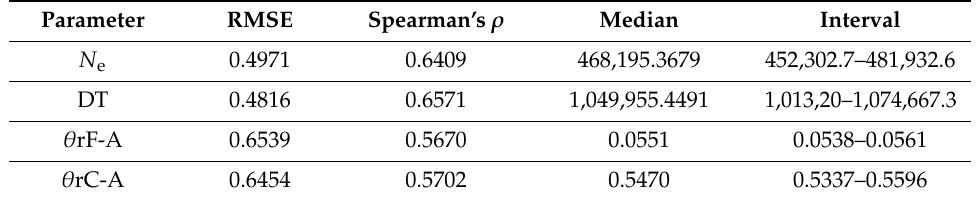
Table 3. Demography parameter estimates of Osteoglossum bicirrhosum based on the selected demographic model. N e —E ff ective population size; DT—divergence time between the two basins; θ rF-A—Population size reduction ratio during colonization; θ rC-A—the ratio between the current